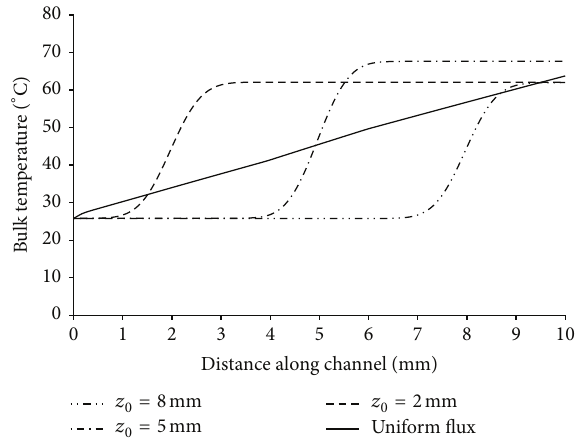
Figure 9: Variations in fluid bulk temperature obtained using different values of 𝑧 𝑚 , when SD = 0.001, Re = 500, 𝜀 = 0.95 , and 𝐶 = 100